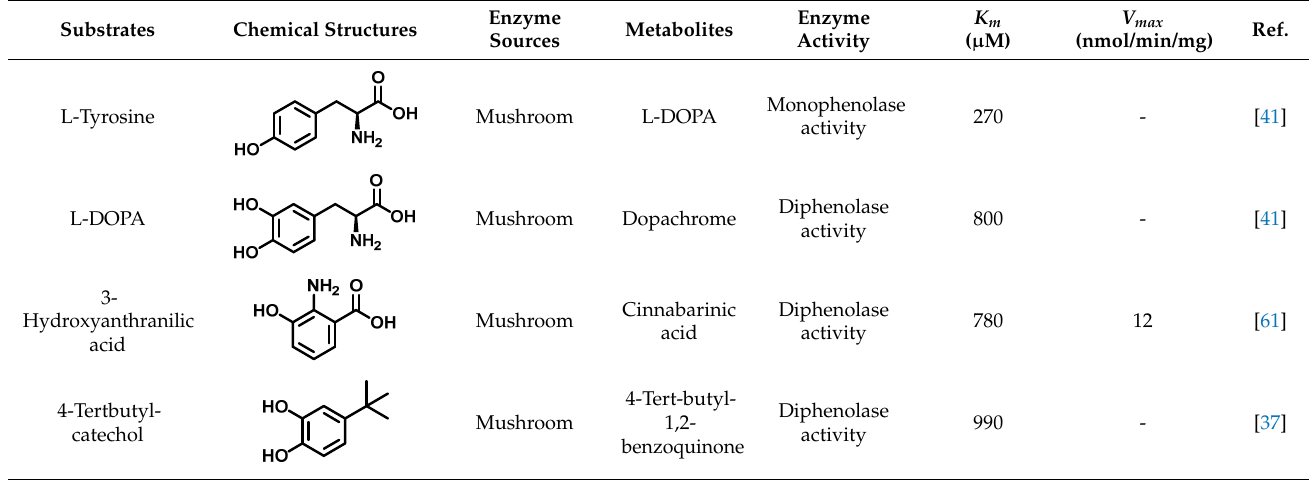
Table 2. Table 2. Table 2. Non-fluorescent substrates of TYR. Table 2. Non-fluorescent substrates of Table 2. Non-fluorescent substrates of TYR. Table 2. Non-fluorescent substrates of TYR. Table 2. Non-fluorescent substrates of TYR.